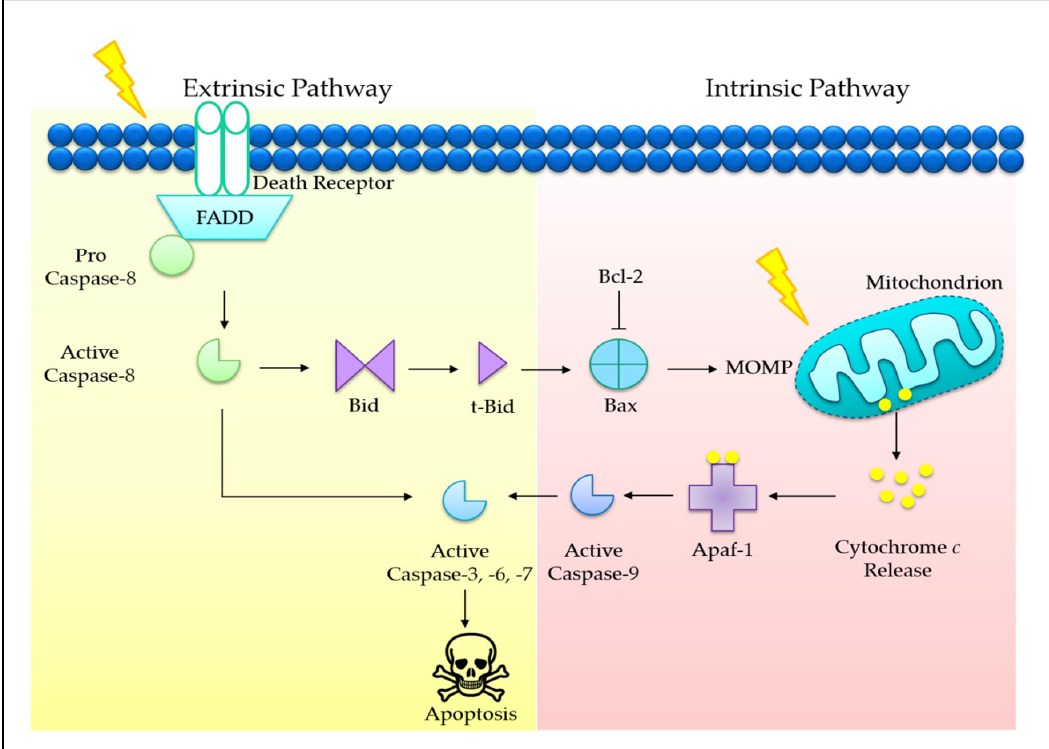
Figure 1. Extrinsic and intrinsic pathways of apoptosis. The extrinsic pathway begins outside of a cell and involves the binding of extracellular death ligands to their respective transmembrane death receptors. The activation of tumor necrosis factor (TNF) receptor superfamily, such as first apoptosis signal (Fas), takes place, leading to activation of caspase-8 (initiator caspase) and recruitment of the Fas-associated protein with death domain (FADD) adapter molecule. It transduces a downstream signaling cascade to the effector caspase (caspase-8), leading to the proteolytic activation of caspase-3. In fact, the extrinsic pathway can cause amplification of cascade via intrinsic mitochondrial pathway whereby caspase-8 cleaves Bid to promote mitochondrial outer membrane permeabilization (MOMP) [32]. The intrinsic pathway is initiated by internal stimuli, such as genetic damage, growth factor deprivation, hypoxia, oxidative stress, and flux of calcium ions (Ca 2+ ) [33]. The stimuli then perceive cell death signals via the mitochondrion, which represents the metabolic status of a cell. The MOMP is often regarded as the primary step required for activation of caspases. Proapoptotic and antiapoptotic B-cell lymphoma 2 (Bcl-2) family proteins are involved in regulating the permeability of outer mitochondrial membrane [34,35]. Upon apoptotic stimulus, MOMP takes place, leading to the release of cytochrome c from the intermembrane space. In the cytoplasm, cytochrome c engages apoptotic protease activating factor 1 (Apaf-1) and eventually leads to the activation of caspase-9 (initiator caspase). Following that, caspase-9 activates executioner caspases, such as caspase-3, -6, and -7, which subsequently cause the downstream biochemical events, leading to apoptosis [36].